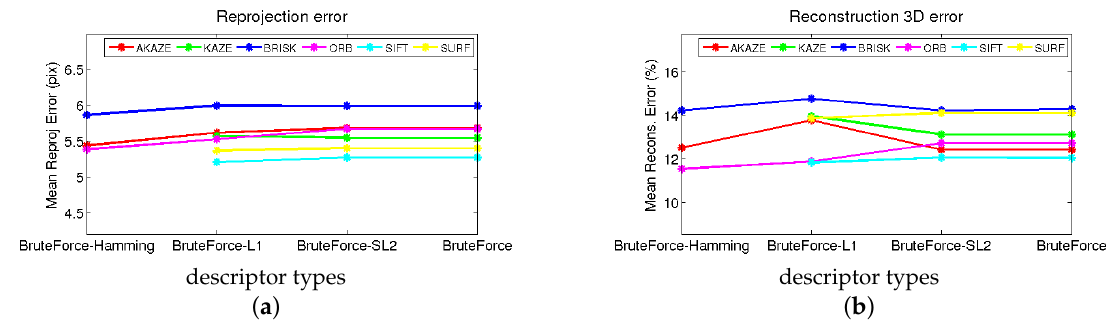
Figure 7. Rendered flag sequence rank based on the error results of the different descriptor methods. ( a ) Reprojection error; ( b ) 3D reconstruction error.